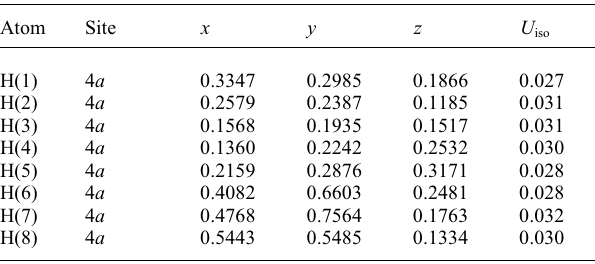
Table 2. Atomic coordinates and displacement parameters (in Å 2 )